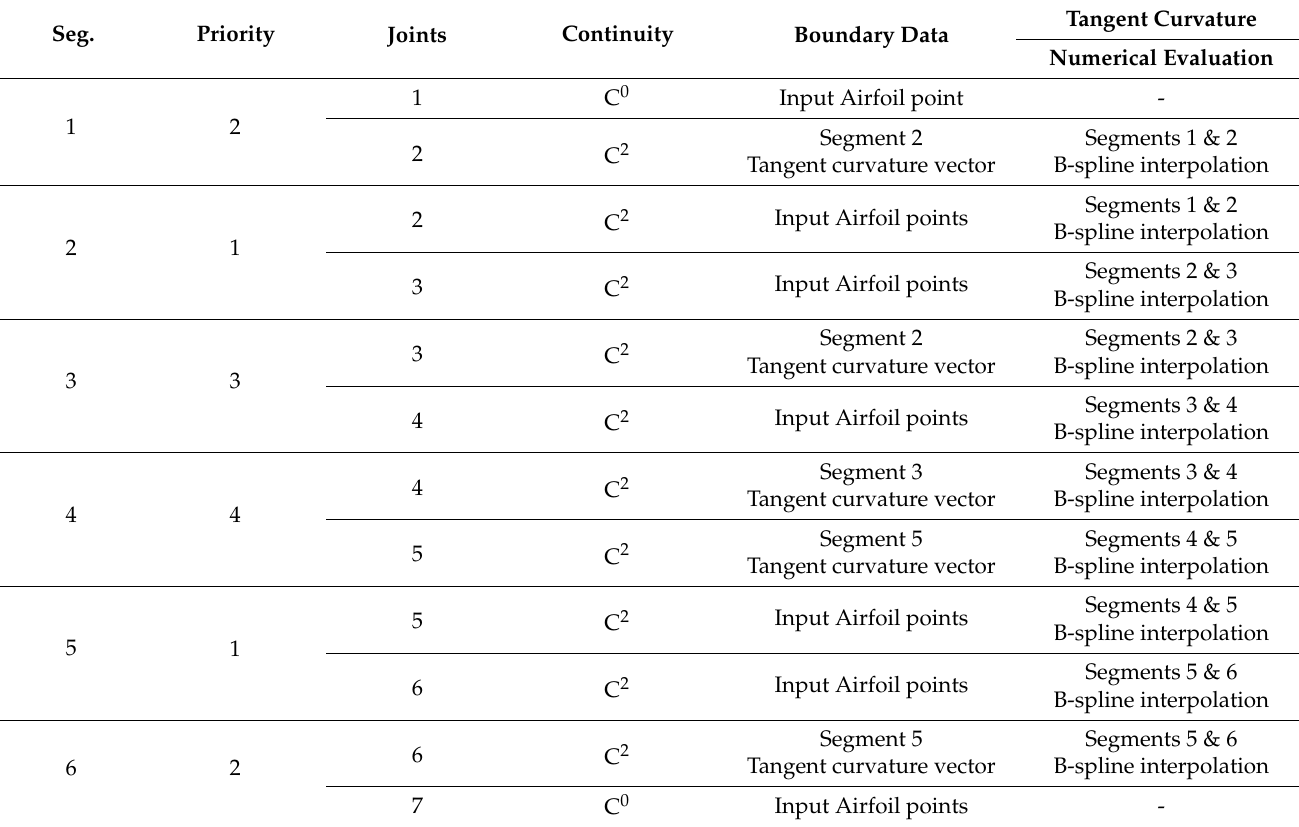
Table 7. Segment-wise strategy boundary conditions